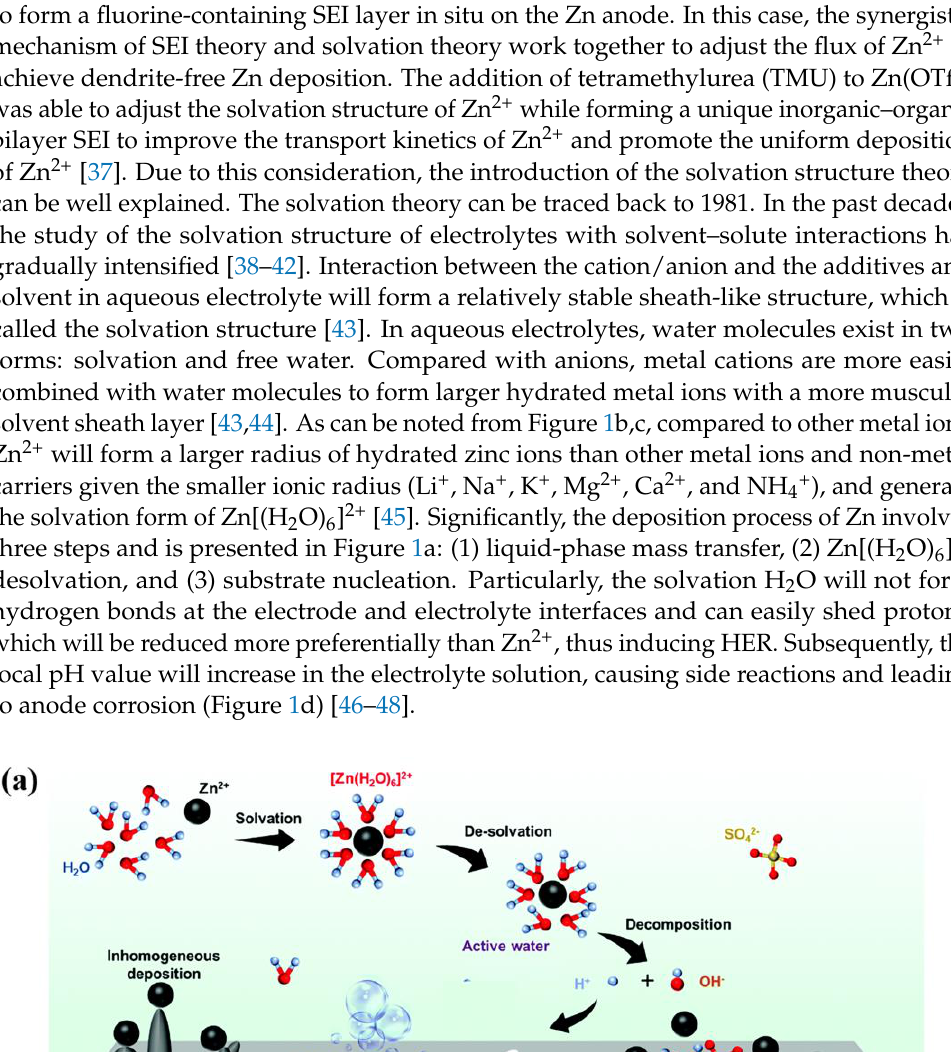
Figure 2. Schematic illustration of solvation structure regulation strategies.